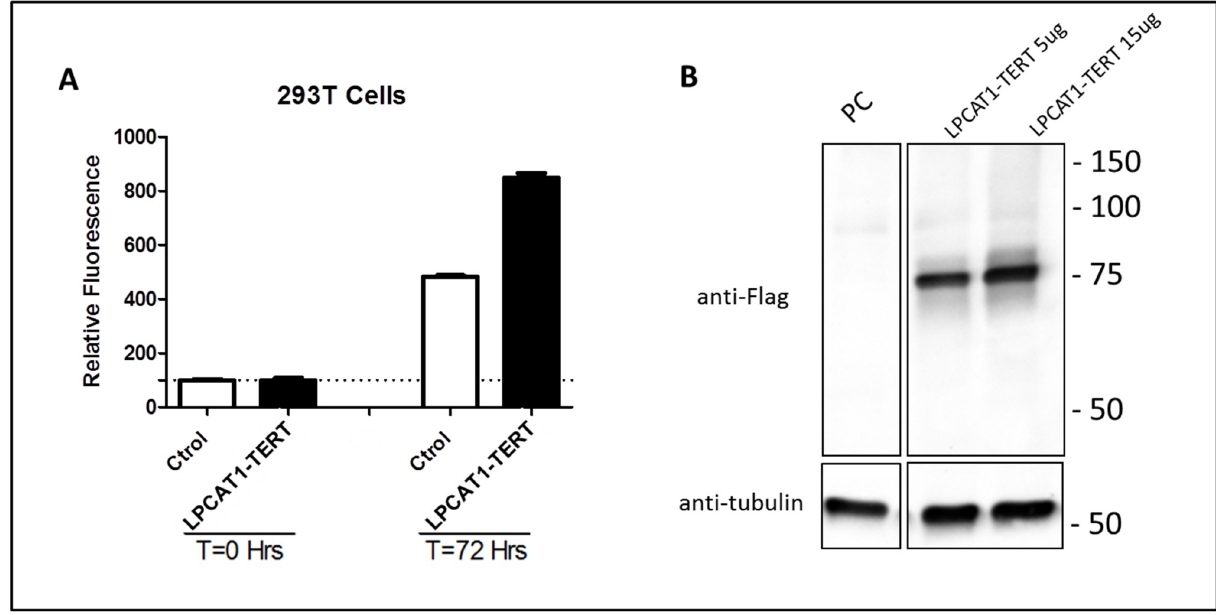
Fig 5. LPCAT1-TERT fusions positively regulate cell growth. A) Cell viability measured at 0 and 72 hours utilizing fluorimetric indicator dye resazurin. Increased metabolic capacity of pcDNA-LPCAT1-TERT-Flag cells demonstrate increased viability (sample size = 5). B) Western Blot confirms expression of LPCAT1-TERT fusion protein in 293T cells using 293T cells transfected with pcDNA control vector or pcDNA-LPCAT1-TERT-Flag and anti-flag antibody or anti-tubulin as control (PC = pcDNA control vector).